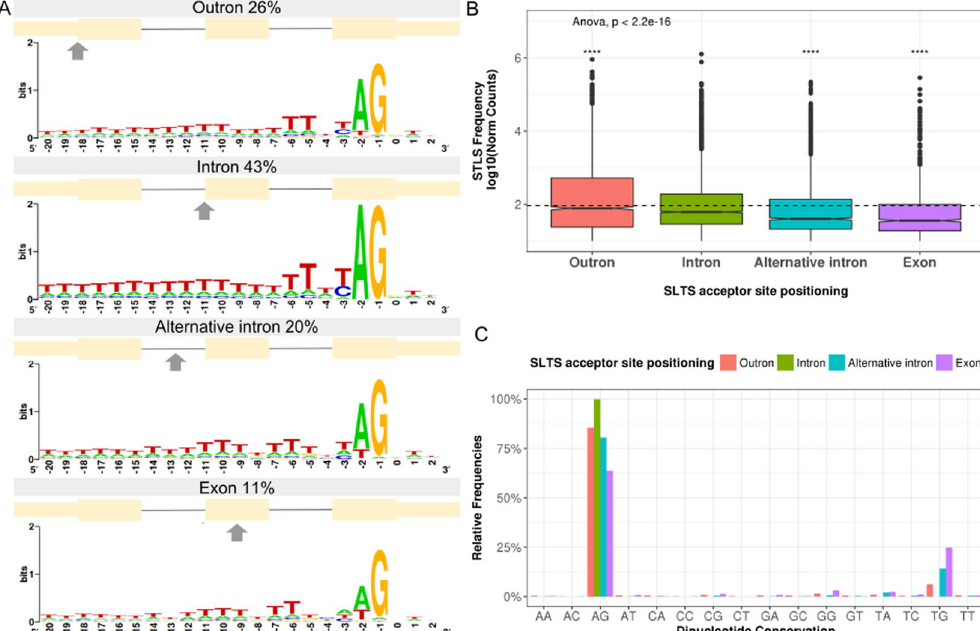
Figure 5. Comparison between different positioning of acceptor sites in outrons and in introns subject to SLTS. ( A ) Relative number of cases and sequence logos of predicted acceptor sites in different positions according to the gene annotation. The positions of acceptor sites resulted from the mapping of SL Trapping reads. SLTS acceptor sites occurring in the first exon of transcripts, in the intron-exon junction, in the intron but upstream to the main acceptor site or located in the exon were named as outron, intron, alternative intron and exon, respectively. ( B ) Quantitative SLTS frequency in each of the different acceptor sites. ANOVA followed by pairwise t-test: **** p < = 0.0001. ( C ) Distribution of the dinucleotides found in each SLTS acceptor site positioning (pink bars - outron, green bars - intron, blue bars - alternative intron and purple bars -